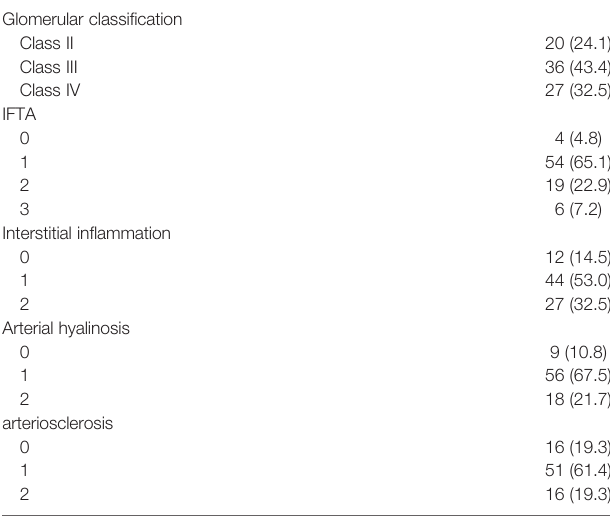
TABLE 2 | Pathologic classi fi cations of patients with diabetic kidney disease. Glomerular classi fi cation Class